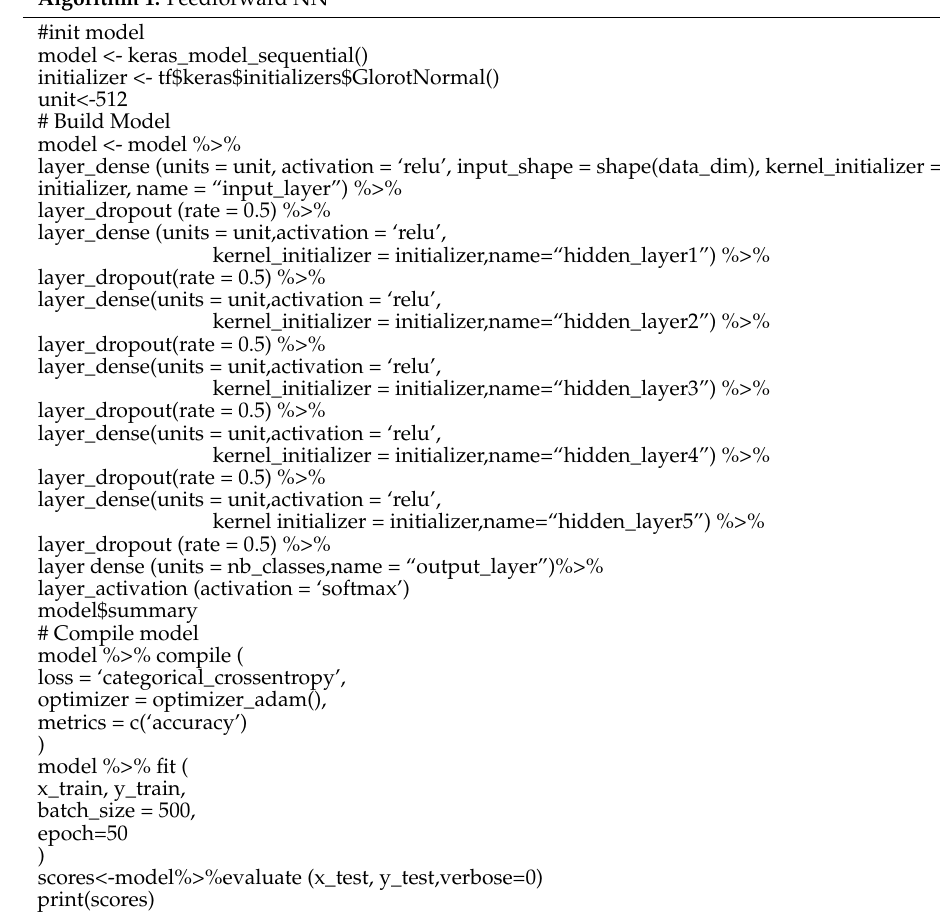
Algorithm 1. Feedforward